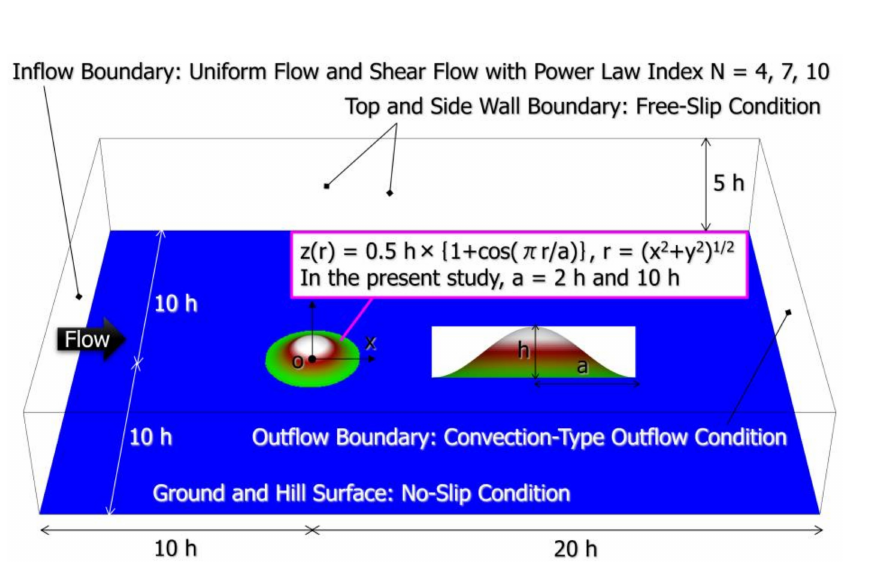
Figure 2. Computational domain, co-ordinate system, and boundary